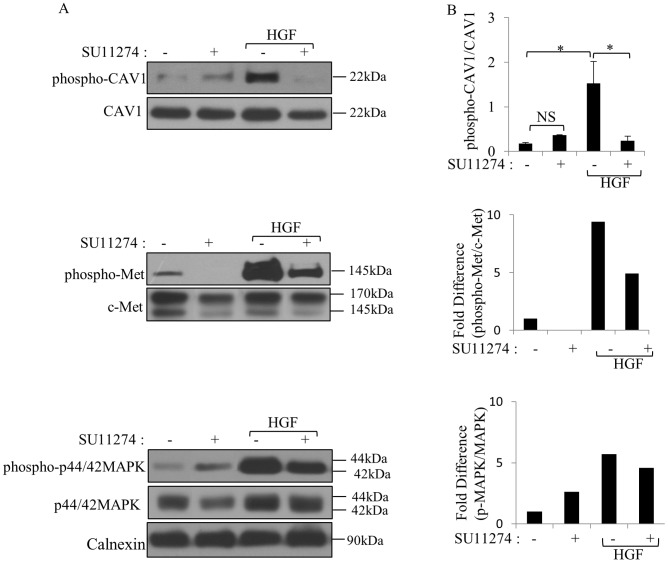
SU11274 inhibited c-Met and downstream signaling.
A. After overnight starvation and SU11274 pretreatment, SNU-449 cells were stimulated with HGF for 15, 30, 60 min or left un-stimulated. Lysates were immunoblotted with indicated antibodies. Calnexin was used as loading control. B. Band intensities of phospho-CAV1 were quantified by densitometry and normalized to CAV1 (n = 3) (*p<0,05, NS: not significant). The relative phospho-Met/c-Met and p-MAPK/MAPK for the different treatments relative to the levels present in corresponding untreated control samples are compared in the bar graphs (n = 3).